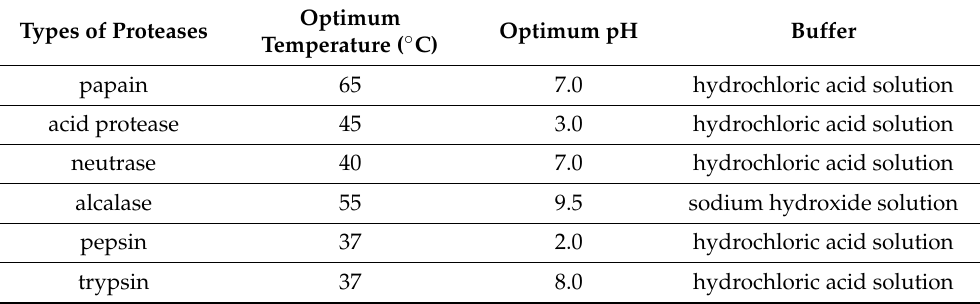
Table 1. Optimal reaction conditions of proteases.